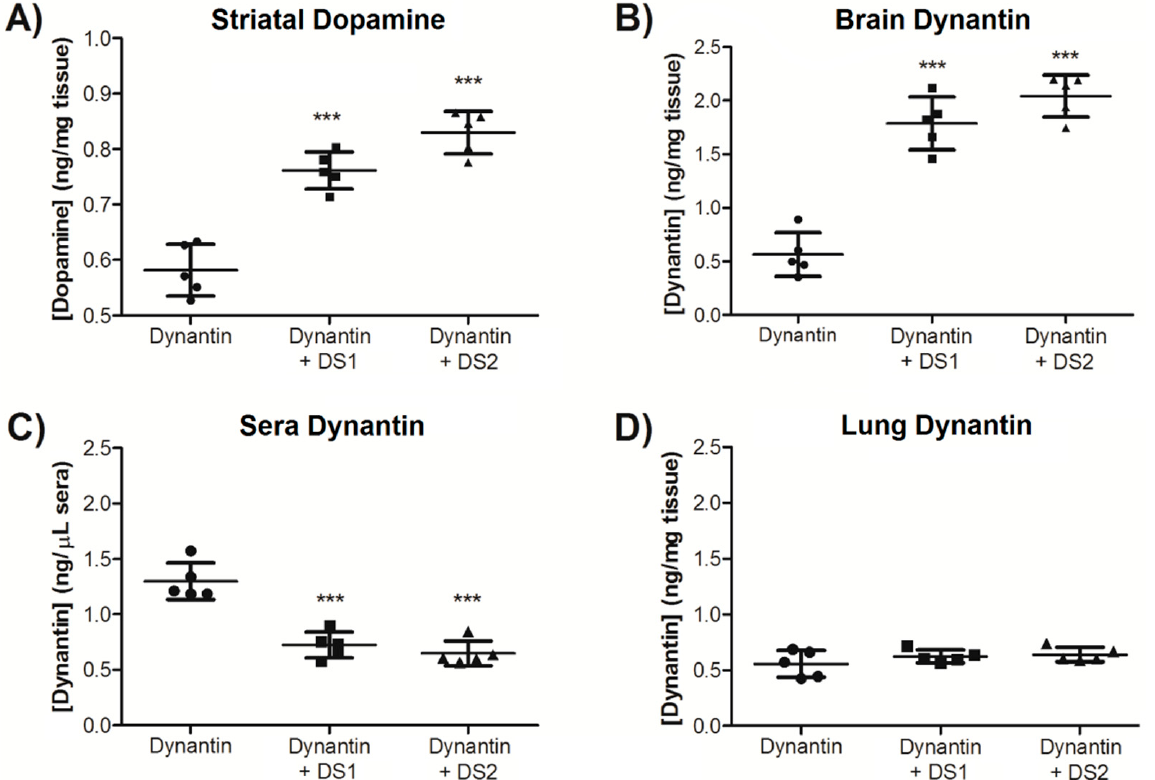
Figure 5. Dynantin in vivo distribution and dopamine modulation. Dynantin (2.0 µ g total dose) was administered intranasally to female BALB/c mice (5 per group) either alone or entrapped with DS1 or DS2 (1:5 ratio of peptide: particles). The mice were euthanized 20 min after administration and the lung, brain, and blood (sera) were collected. Brains were immediately dissected on ice to obtain striatum tissue from which dopamine was extracted and its levels analyzed by LC/MS in the presence of 0.1% formic acid ( A ). Dynantin was extracted from the remaining brain tissue ( B ), sera ( C ), and lungs ( D ) after lyophilisation and levels of dynantin quantified by RP-HPLC in the presence of 0.1% trifluoroacetic acid and detection by absorbance. Data are shown as the average ± SD of the 5 mice in each group. *** p < 0.001 as compared to the peptide devoid of a delivery system. Table 1. Dynantin in vivo distribution represented as the percentage of total dose recovered from organ and sera samples.